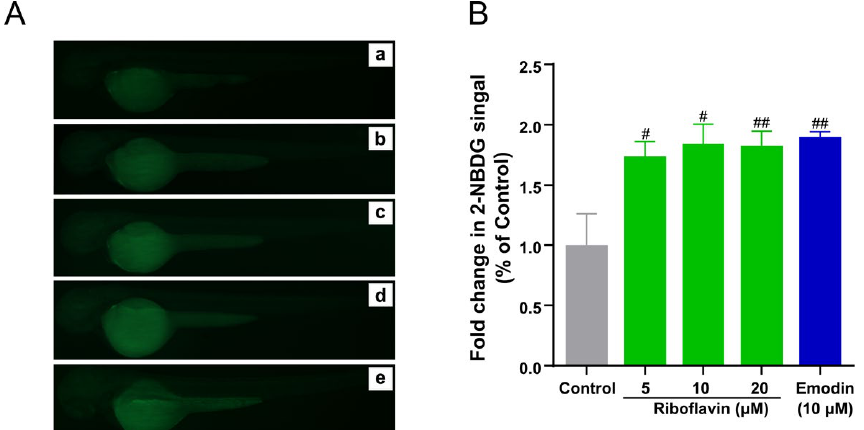
Figure 6. Riboflavin induces 2-NBDG uptake in zebrafish larvae. ( A ) Fluorescence microscopy images of zebrafish larvae treated with different concentrations of riboflavin (5, 10, 20 µ M) with 10 µ M emodin as a positive control. Control (a), 5 µ M riboflavin (b), 10 µ M riboflavin (c), 20 µ M riboflavin (d) and 10 µ M emodin (e). ( B ) Fold change in 2-NBDG absorption quantified by Image J. Results are expressed as mean ± SEM. ## p < 0.01, # p < 0.05 vs. control.